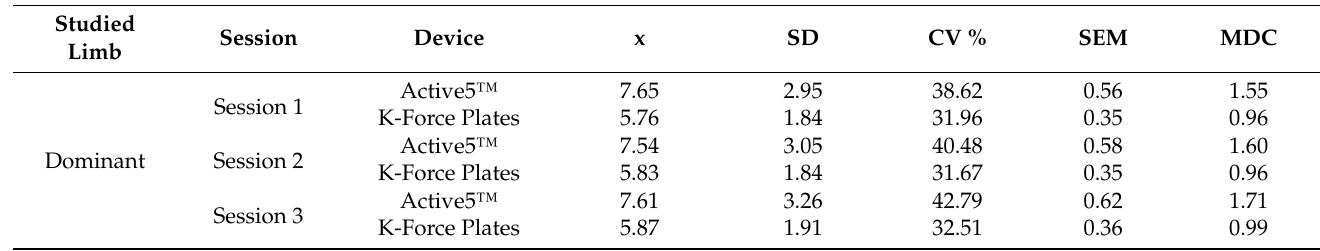
Table 14. The results of force measurements at 135 ◦ of shoulder abduction using Active5™ and K-Force